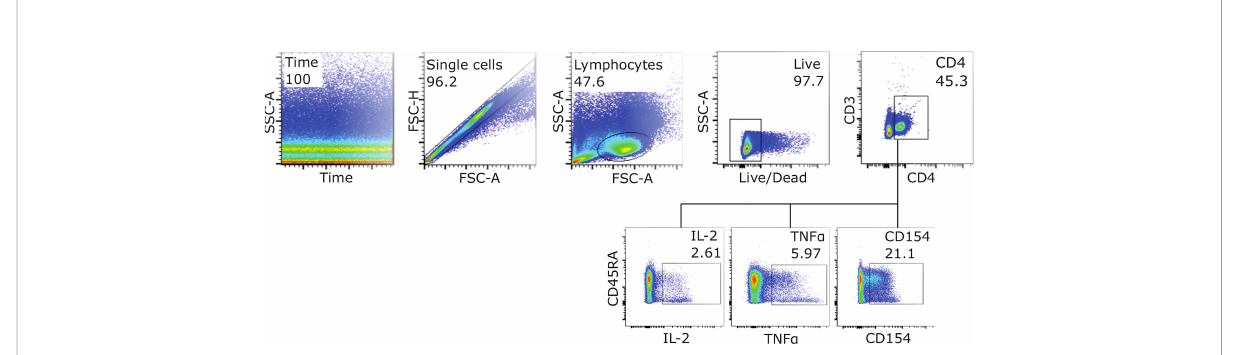
FIGURE 1 Gating strategy for detection of activated CD4 + T-cells. Example FACS plots from SEB stimulated infant PBMSs at D128, showing the gating strategy used to measure the expression of activation markers IL-2, TNF a and CD154 (CD40L). To assess frequencies of cells expressing all three markers, Boolean gating was